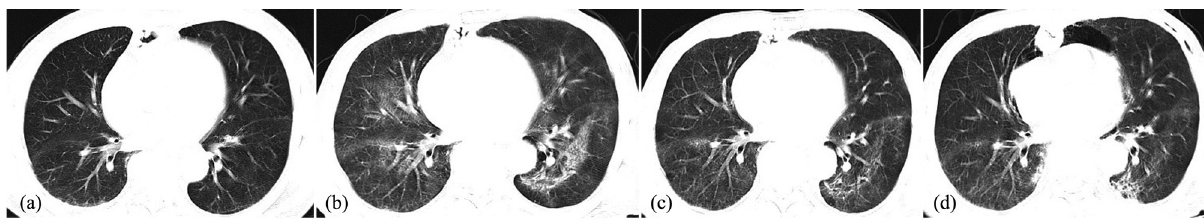
Figure 2: Changes in lung computed tomography scan. ( a ) At the beginning of the disease, the two lower lungs showed mild in fl ammation and exudation. ( b ) One month later, lung exudation aggravated; the clinical symptoms were chest tightness and shortness of breath. ( c ) Two weeks after treatment with methylprednisolone ( 1 mg/kg/day ) , the lesions were markedly absorbed, and the symptoms disap - peared. ( d ) In the last week, pulmonary in fl ammation exacerbated, and mediastinal pneumothorax ( arrow ) appeared.